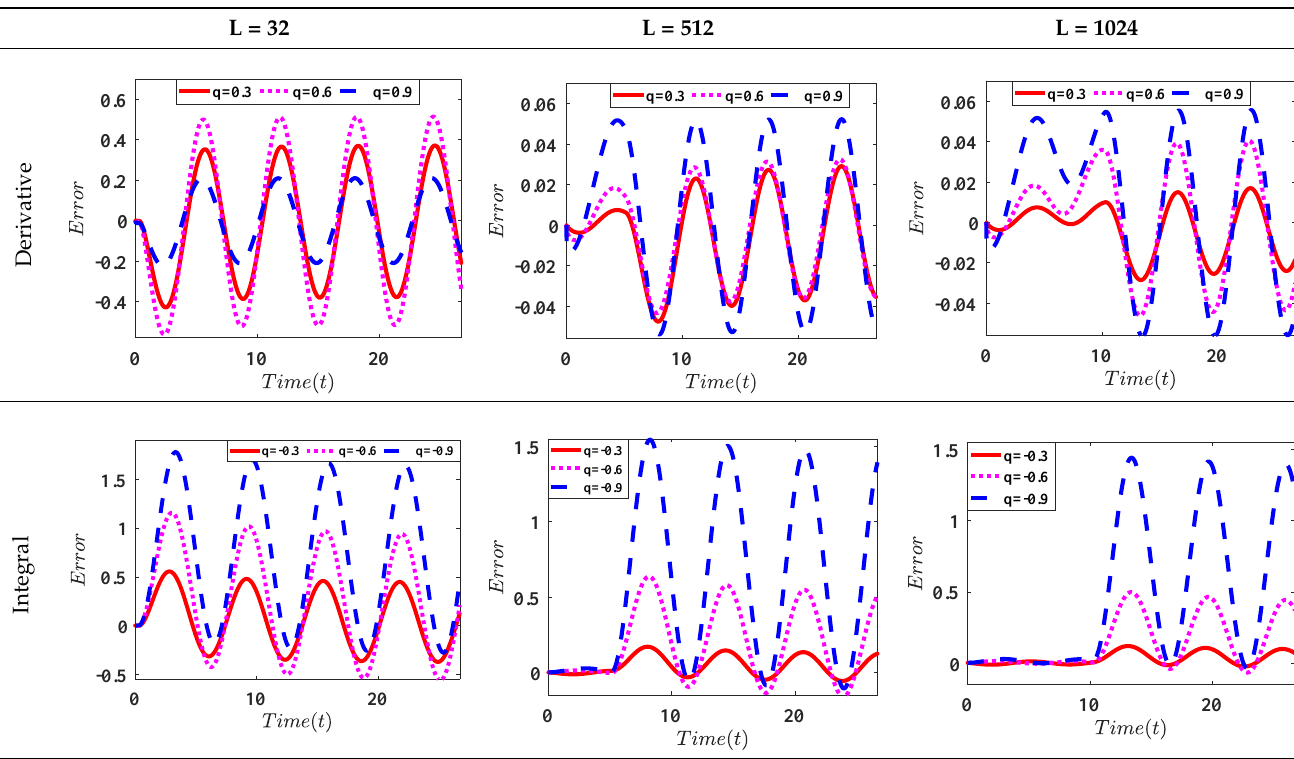
Table 2. The error of the proposed design results (differentiator and integrator) for a sine signal input with respect to MATLAB